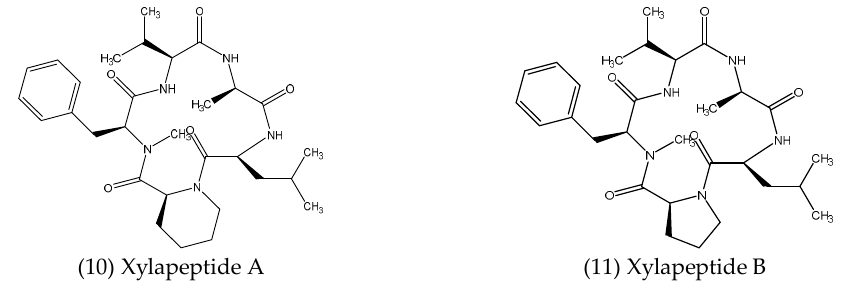
Figure 3. Structures of antimicrobial peptides isolated from endophytes.